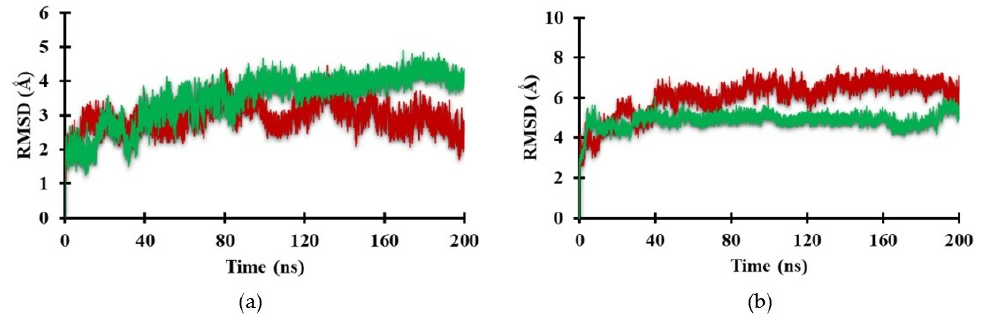
Figure 7. Plot of the RMSD value of backbone in the active site of ( a ) Antagonist-REV-ERB β and ( b ) Agonist-REV-ERB β with Heme (green) and CoPP (red) during the molecular dynamic